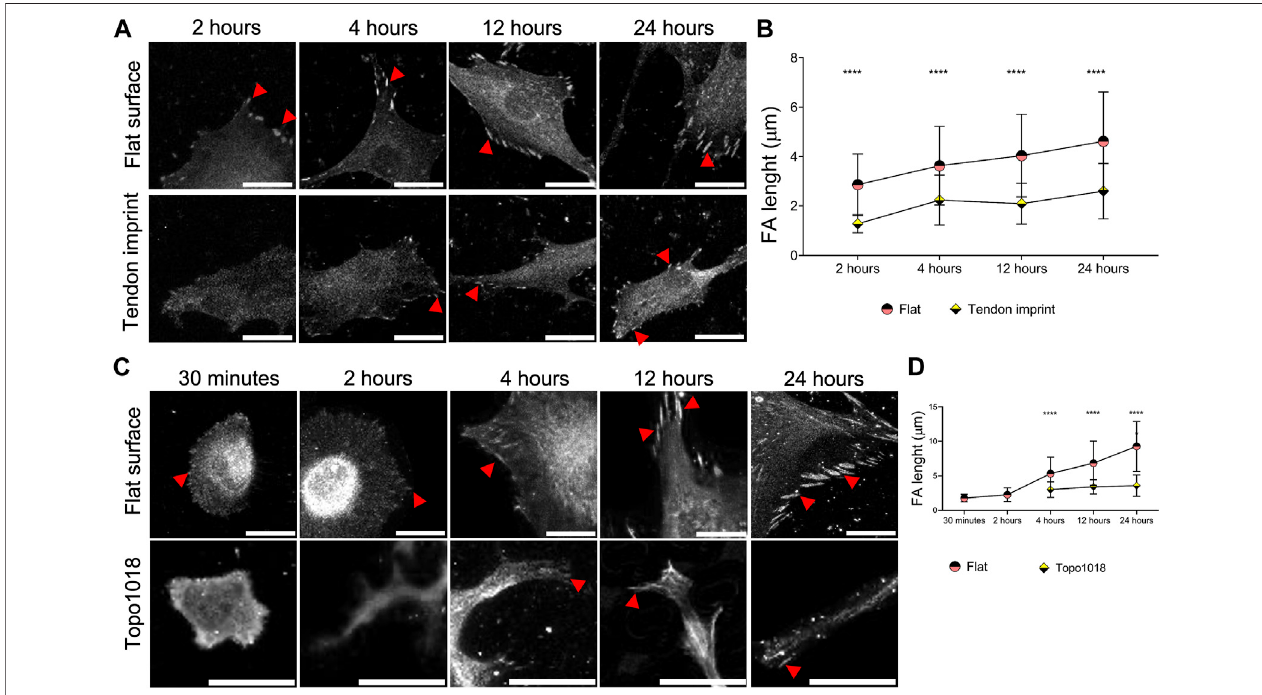
FIGURE4| Surfacetopographymodulatesthematurityandpositionoffocaladhesions. (A) Rattenocytesculturedona fl atsurfaceandthetendonimprintfor2,4, 12, and 24 h, and stained for vinculin (fair gray color) and pointed with red arrows. Scale bars represent 20 µM. (B) Quanti fi cation of focal adhesion length indicates that on a fl at surface, as the cells become larger, focal adhesions become longer indicating their maturation. Tenocytes on the tendon imprint, focal adhesion length is signi fi cantly smaller compared to the fl at surface at the all-time point. (C) hMSCs cultured on a fl at surface and a Topo1018 surface for 30 min, 2, 4, 12, and 24 h, and stained with vinculin (fair gray color) and pointed with red arrows. Scale bars represent 20 µM. (D) Focal adhesion length increases steadily in cells cultured on a fl at surface.OntheTopo1018surface,wedidnotobservefocaladhesionsafter30 minand2 h,andfrom4 honward,theirlengthremainedatsimilarlevelsandsigni fi cantly shorter compared to their fl at surface counterparts. (Error bars represent 95% con fi dence intervals, **** p < 0.001) (* ’ s correspond to comparisons between different culture substrates in the same time point). For all experiments, N = 3. (FA = focal adhesion).